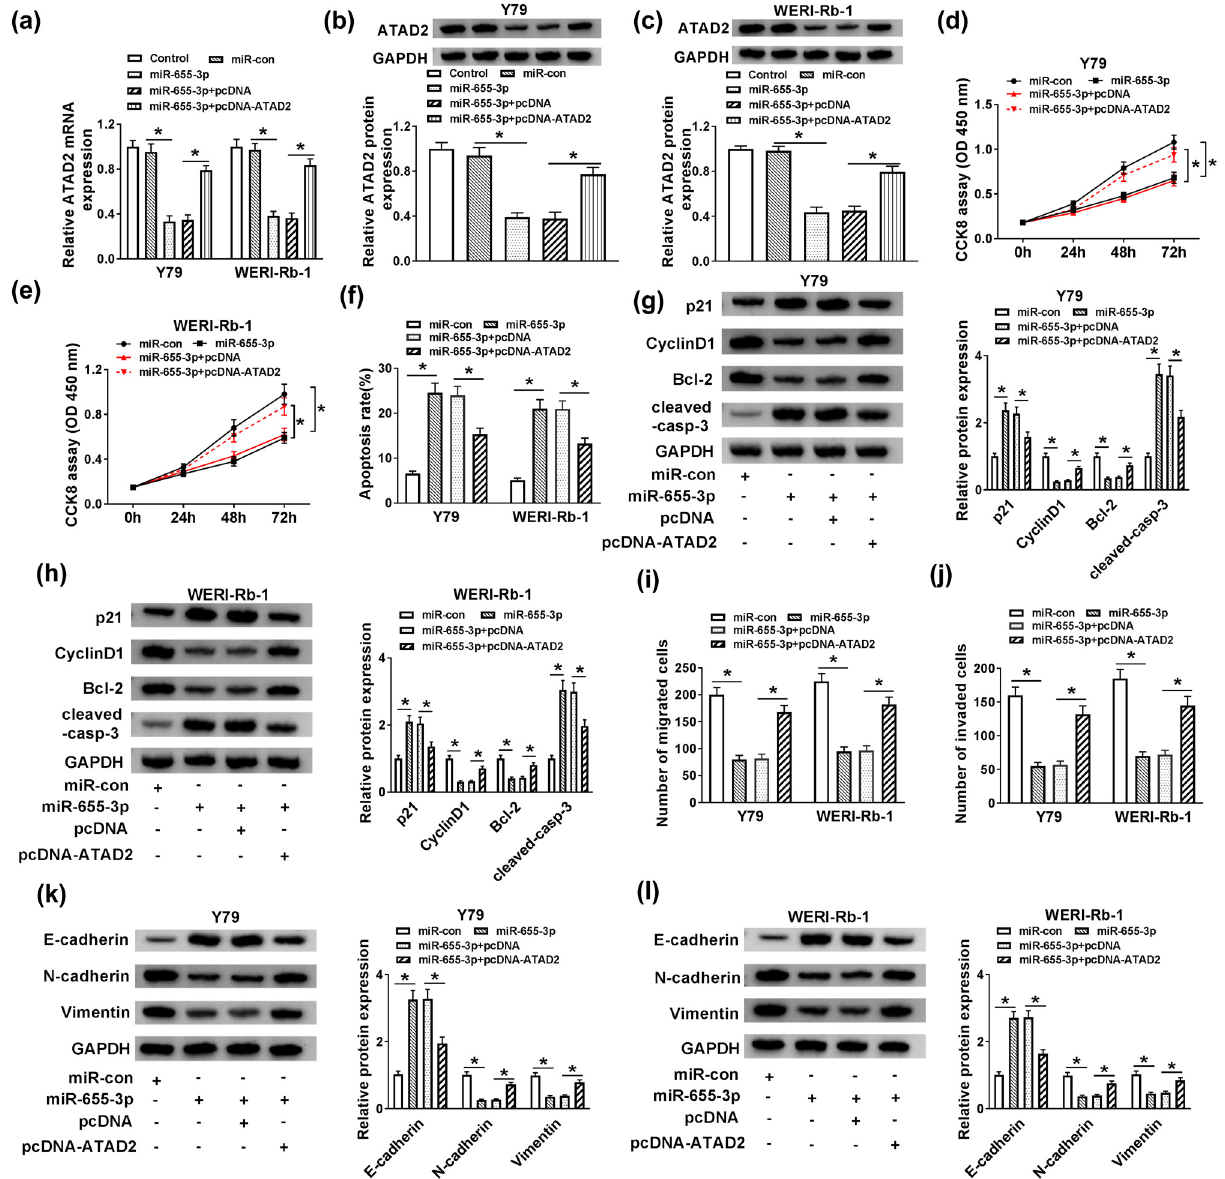
Figure 6: miR - 655 - 3p negatively regulated ATAD2 expression to impede cell proliferation and impel apoptosis in Y79 and WERI - Rb - 1 cells. ( a – c ) The Y79 and WERI - Rb - 1 cells were transfected with Control, miR - con, miR - 655 - 3p, miR - 655 - 3p + pcDNA, or miR - 655 - 3p + pcDNA - ATAD2. The levels of ATAD2 mRNA and protein were detected via RT - qPCR and western blot assay. ( d – l ) The Y79 and WERI - Rb - 1 cells